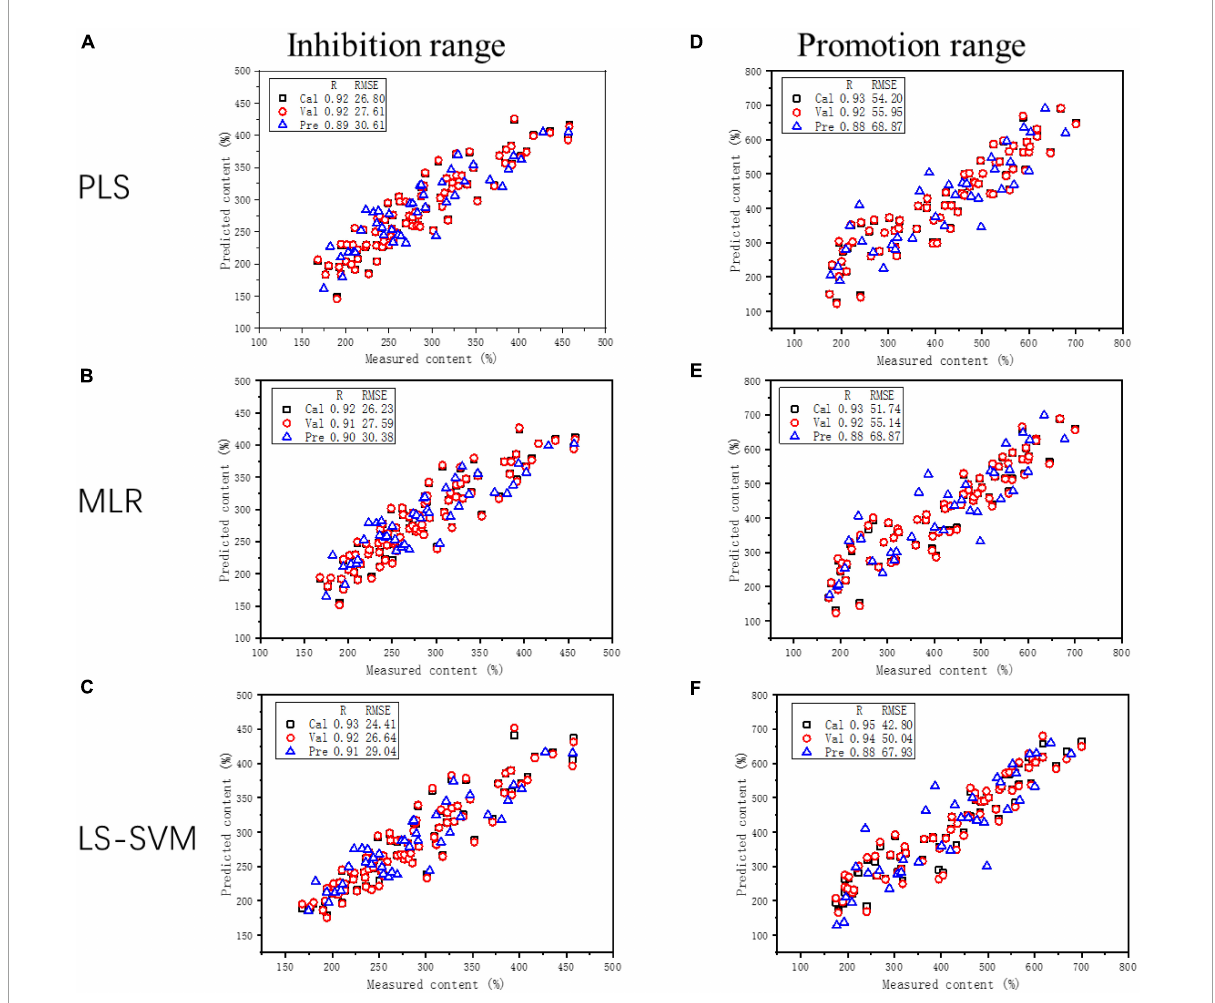
FIGURE5 Graphs of three models (PLS, MLR, and LS-SVR) for estimating the correlation between predicted concentrations and measured values and showing both inhibition and promotion effects on acrylamide formation. Inhibition range of PLS, MLR, and LS-SVR model are presented in panels (A–C) , respectively; Promotion range of PLS, MLR, and LS-SVR model are presented in panels (D–F) , respectively.